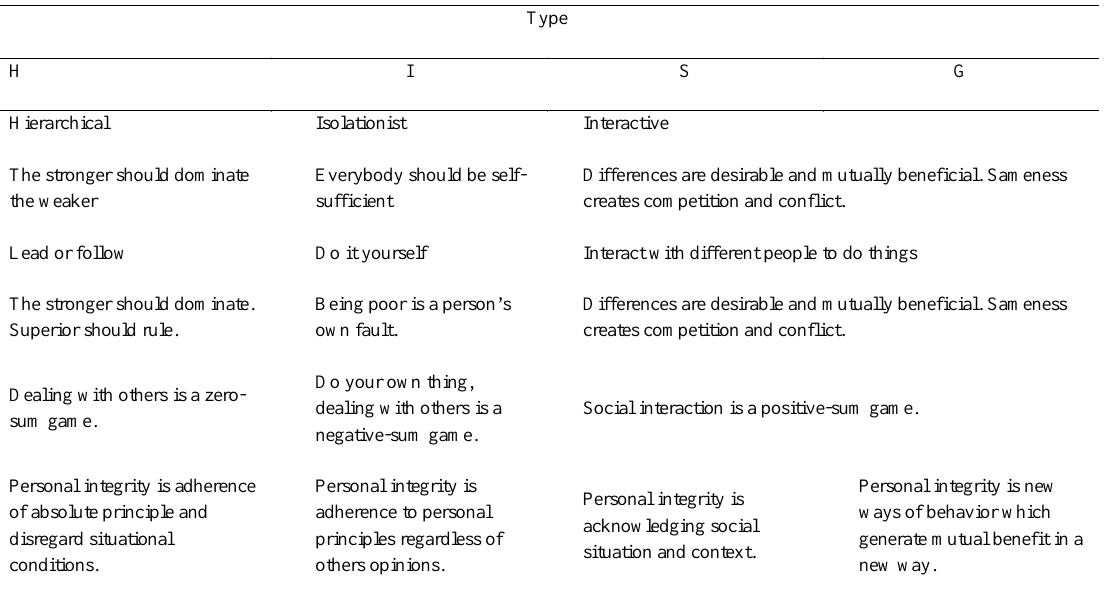
Table 1: Ethical precepts of mindscape